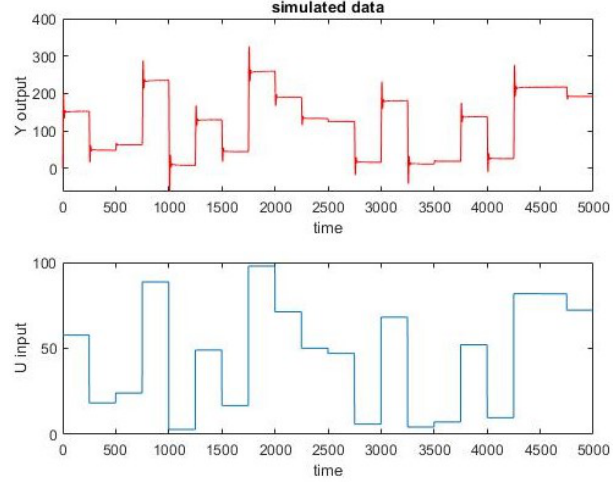
Figure 16. Simulated data with the original fractional transfer